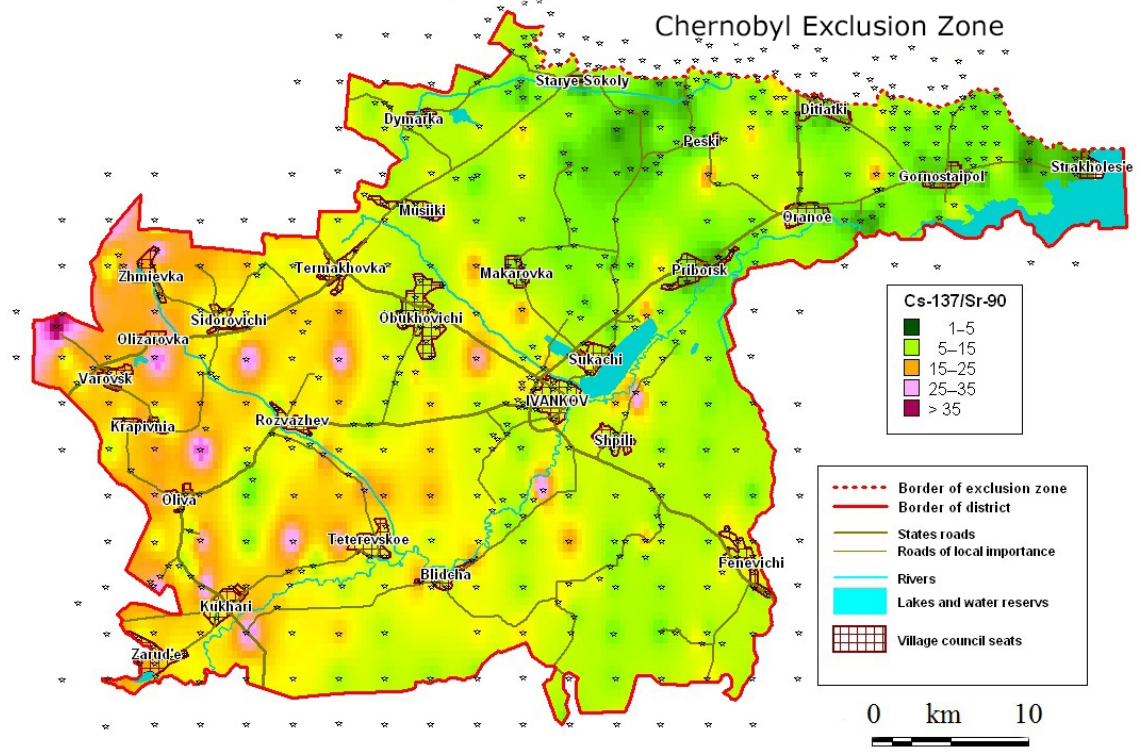
Figure 5. Spatial variation in 137 Cs: 90 Sr ratio in the Ivankov district (sampling points are shown as black